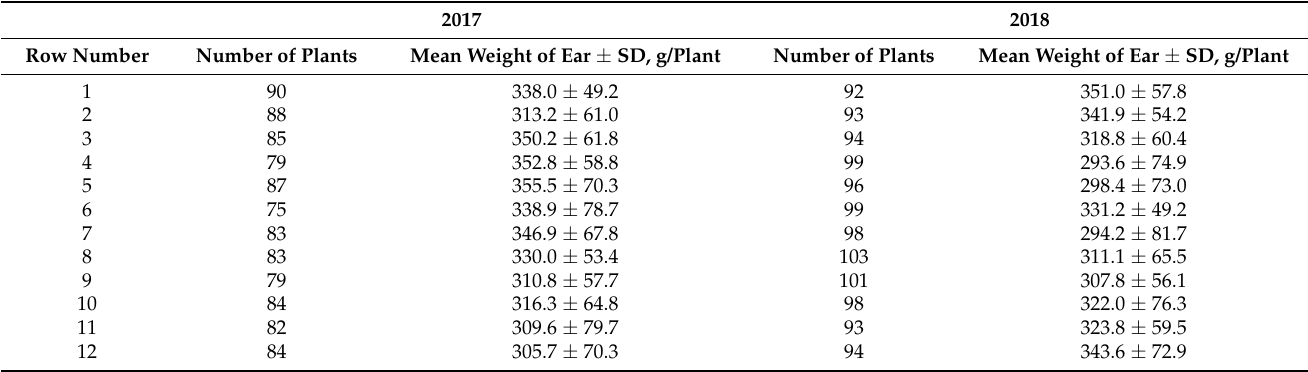
Table 1. Raw data statistics. Mean and standard deviation (SD) for the ear weight, and the number of plants are given by rows for the years 2017 and 2018.